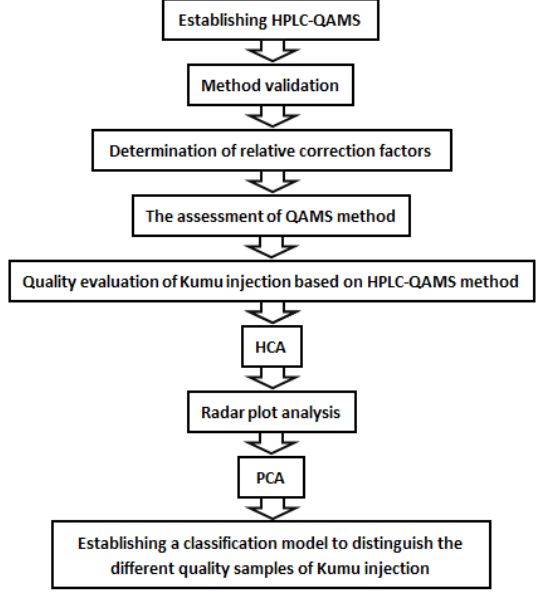
Figure 5. Flow diagram of the experiment.